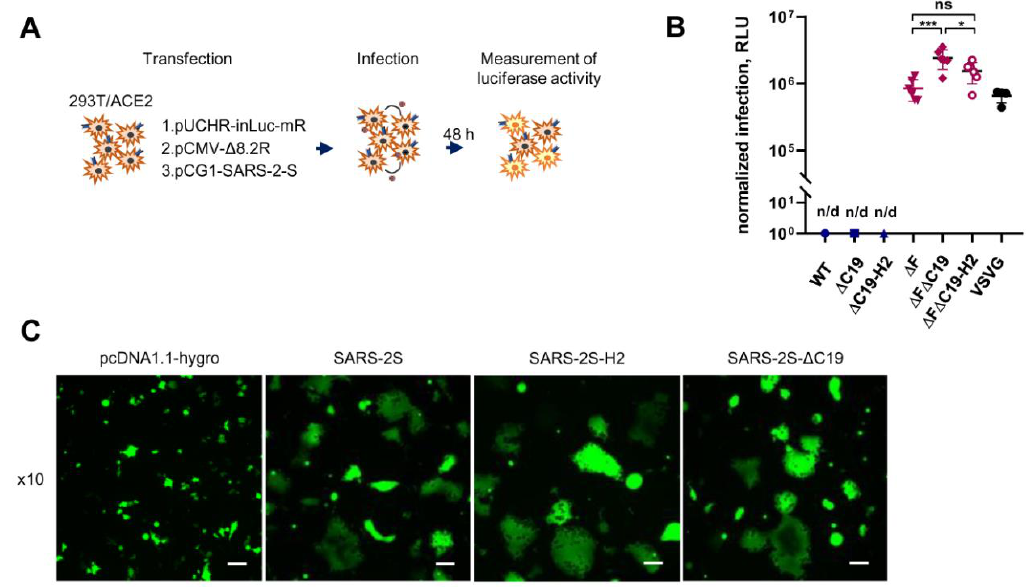
Figure 2. Establishing PV system for measurement of SARS-CoV-2 cell coculture infection. ( A ) A schematic representation of SARS-CoV-2 one-step transfection–infection assay in 293T/ACE2. ( B ) The levels of infectivity measured using one-step assay with different spike protein mutants. Samples with the intact furin cleavage site produced no signal above background (n/d). The differences between ∆ F mutants were calculated by one-way ANOVA with Tukey’s multiple comparison test, and were significant at p = 0.0008 (***) and p = 0.0457 (*). Simbols and color codes in ( B ) are the same as in Figure 1D,G. ( C ) Syncytia formation induced by wild-type or mutant SARS-CoV-2 S protein. 293T cells were co-transfected with GFP- expression plasmid and one of the indicated variant of S protein bearing intact furin cleavage site. At 24 h post transfection, cells were detached with 1 mM EDTA and mixed with 293T/ACE2 cells at a 1:1 ratio for another 24 h. Typical images of cells captured on epifluorescence microscope with filters set for FITC are demonstrated (Scale bar, 10 µ